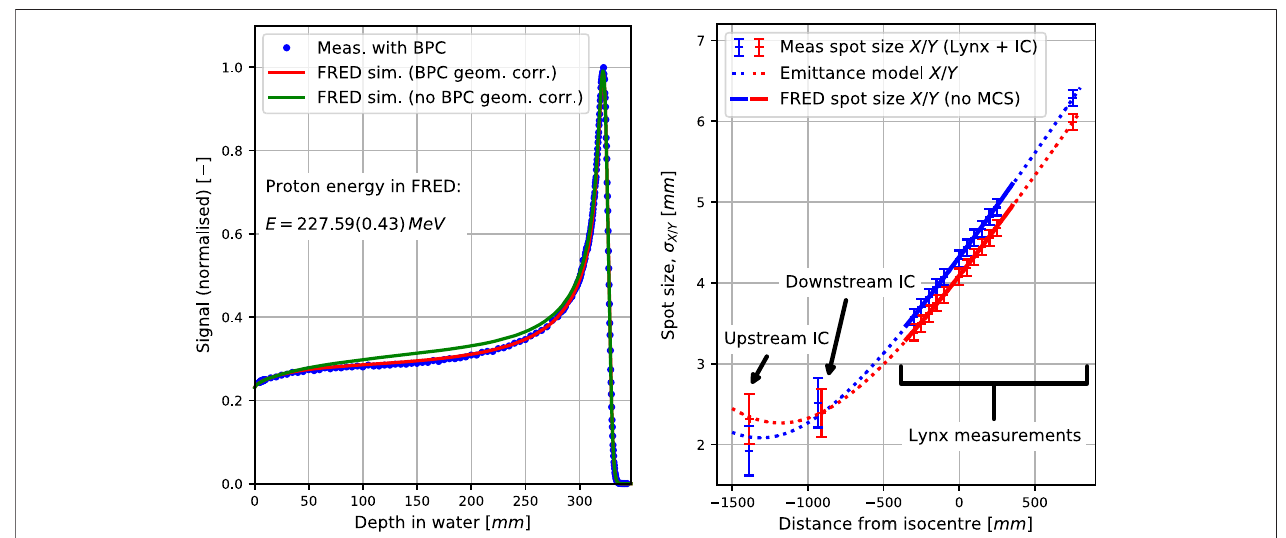
FIGURE3|(Left) BraggpeaksmeasuredwiththeBraggpeakchamber(BPC)ofdiameter81.6 mmandsimulatedfortheoptimalenergyandenergyspreadinthe BPC,mimickingtheexperimentalsetup,aswellasinfull40 × 40 × 40 cm 3 waterphantomforcomparison. (Right) Emittancemodel fi ttomeasuredspotsizes(Lynxand IC) in the in-plane ( X ) and cross-plane ( Y ) directions along with the beam sizes simulated with F RED in air without multiple Coulomb scattering.